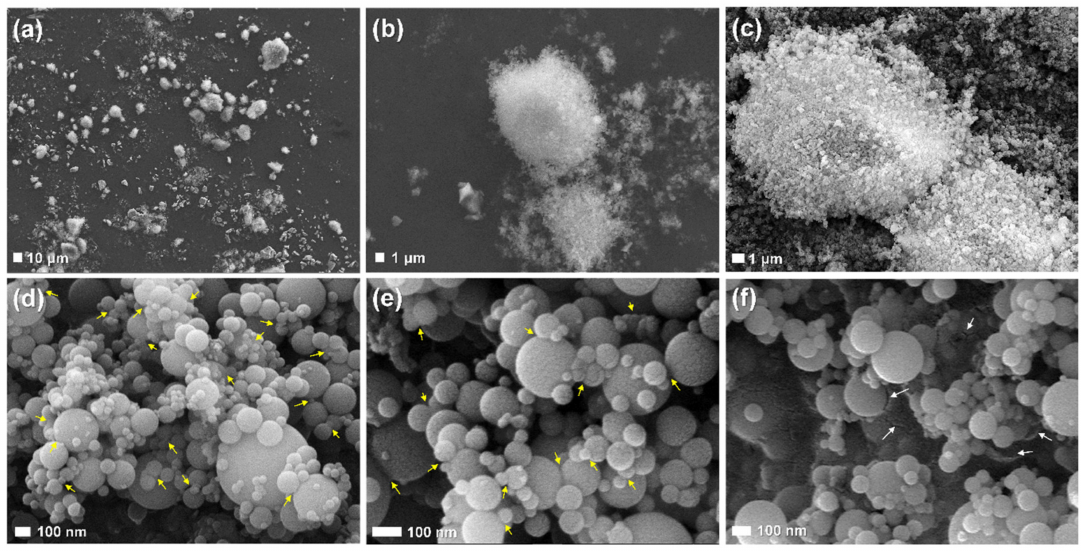
Figure 5. SEM images of SF1_U samples with various resolutions: agglomerated lumps ( a – c ) and spherical nanoparticles ( d – f ) inside